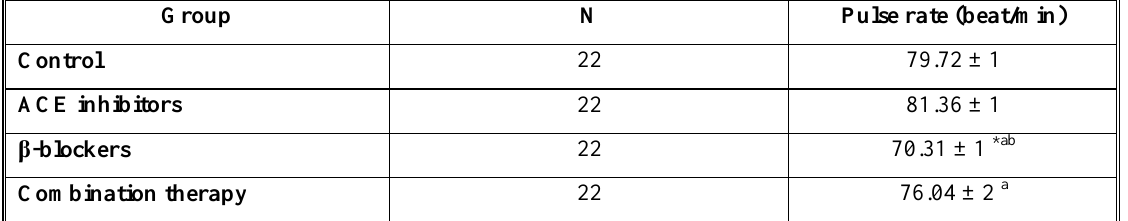
Table 5: Fasting serum glucose in control healthy individuals and non diabetic hypertensive patients treated with different antihypertensive drug regimens. Each value represents mean± standard error of mean .